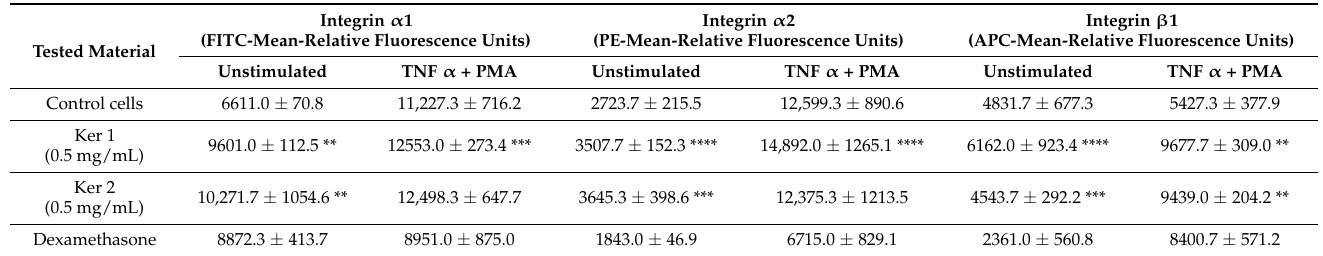
Table 7. Membrane-specific fluorescence quantified through flow-cytometry showing integrins α 1, α 2 and β 1expressed by fibroblast cells (HS27).